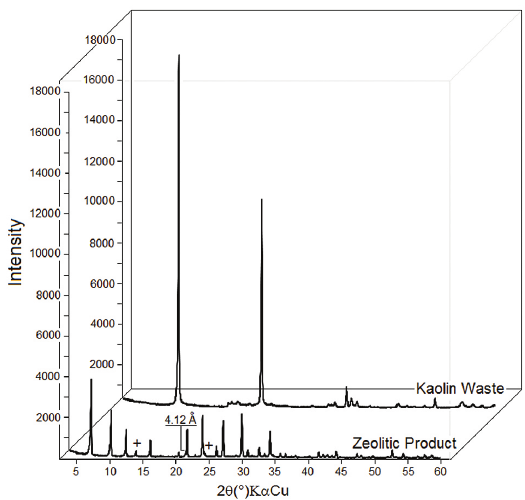
Figure 1. Diffraction patterns of kaolin waste and zeolitic product.